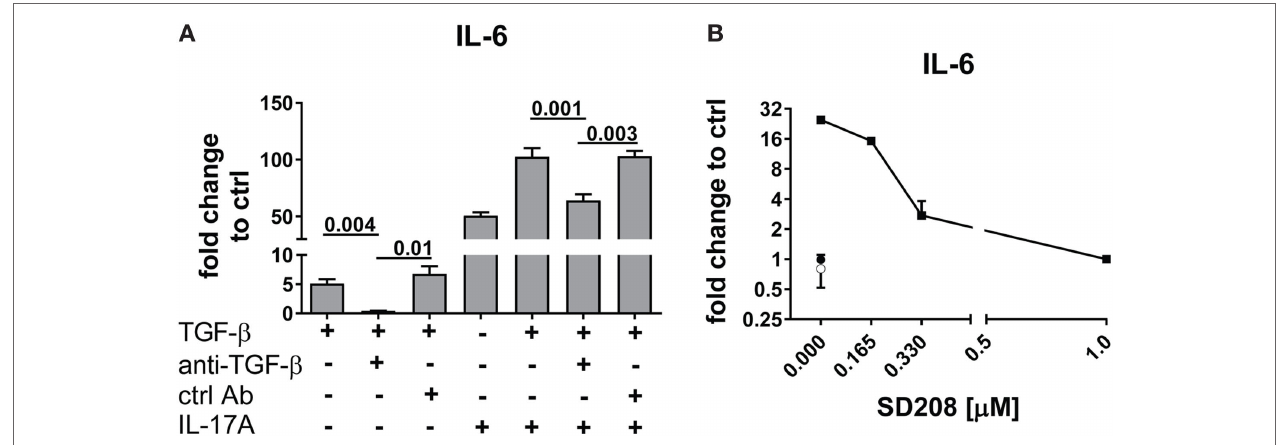
FigUre 2 | TGF- β inhibition abrogates the synergistic response with IL-17A. HD fibroblasts were treated with (a) 10 µg/ml TGF- β 1 neutralizing antibody or 10 µg/ ml of an irrelevant ctrl Ab, (B) SD208 (TGF β R1 inhibitor) or vehicle for 1 h prior to the addition of IL-17A (25 ng/ml) or TGF- β (2.5 ng/ml) and cultured for 48 h. IL-6 levels in SN were assessed by ELISA. Results are shown as fold change to untreated control cultures (basal level of IL-6 was 3.1 ± 1.1 pg/ml). (B) Square: TGF- β (10 ng/ml); empty circle: (SD2018, 1 µM); full circle: vehicle. Significant differences were assessed by paired t -test. Bars in (a) and symbols in (B) represent the mean + SEM of three